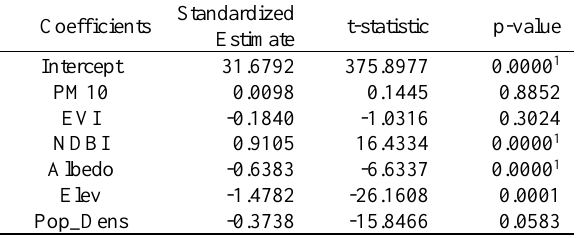
Table 5. 25 th quantile regression results.